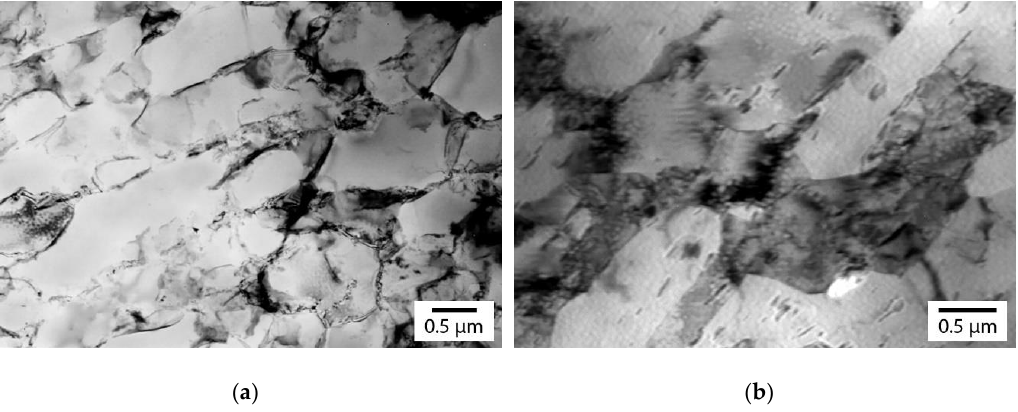
Figure 3. Bright field TEM micrographs of Al 1080 powder after extrusion (longitudinal direction): ( a ) direct extrusion and ( b ) indirect extrusion.